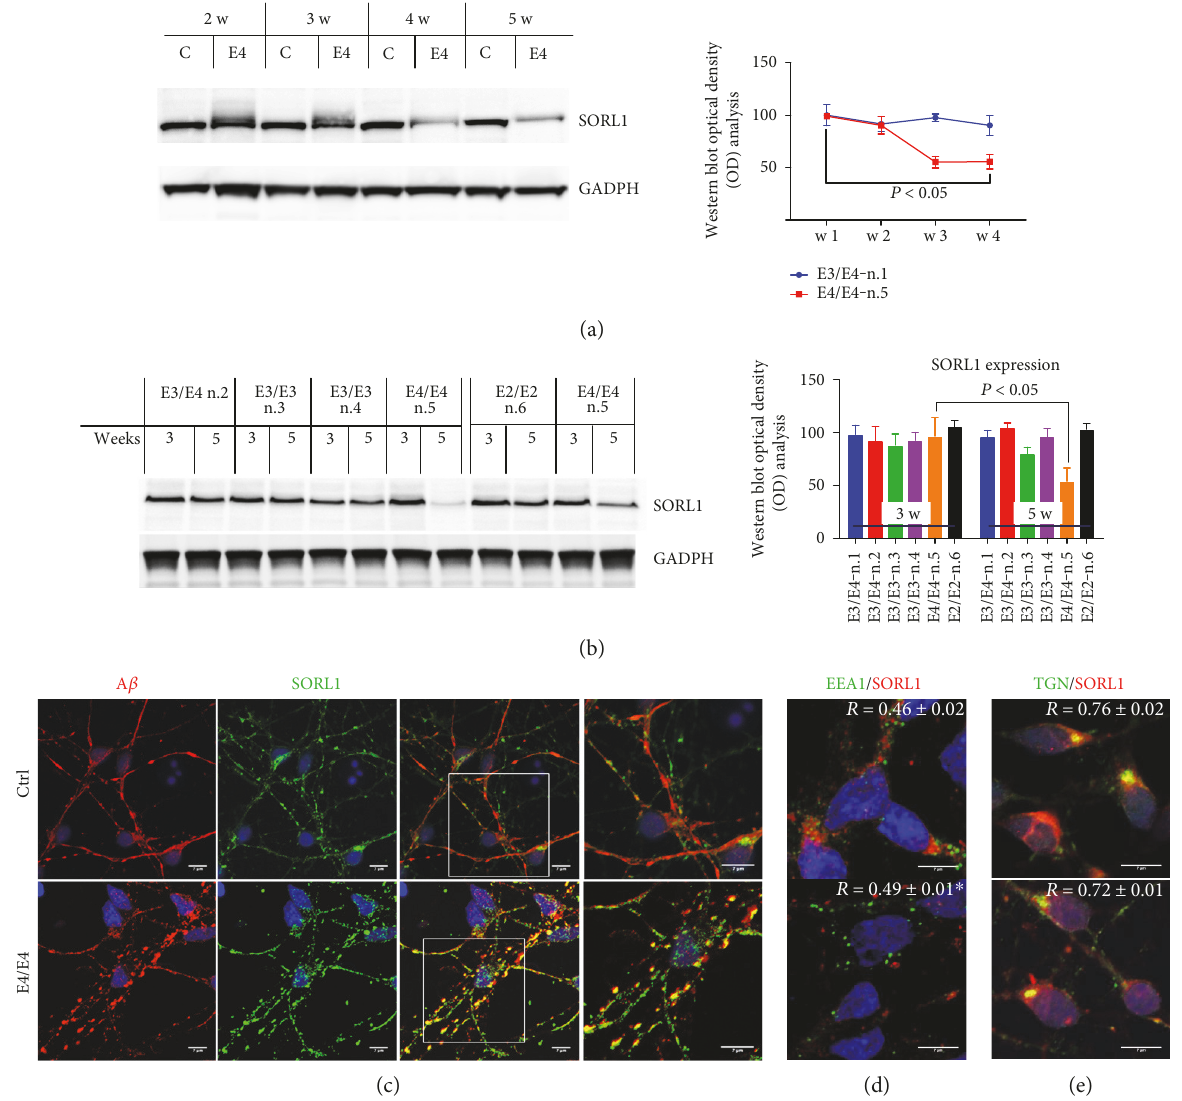
Figure 2: SORL1 expression is decreased in neurons carrying the E4/E4 genotype. (a) WB analysis of SORL1 from control (C, n.1) and E4/E4 (E4) neurons from two to fi ve weeks in culture. SORL1 expression levels were normalized to GADPH and expressed as % of the control (n.1). The quanti fi cation of band intensities (OD) is reported on the right. n = 4 , P < 0 05 versus week three. One-way ANOVA with post hoc Tukey ’ s test. (b) WB analysis of SORL1 in neurons with or without APOE4 allele expression after three and fi ve weeks in culture. SORL1 expression levels were normalized to GADPH and expressed as % of the control (n.1). The fi gure also reports SORL1 expression levels in 74-year healthy donors (n.6). The quanti fi cation of band intensities (OD) is reported on the right. n = 4 ; one-way ANOVA with post hoc Tukey ’ s test. P < 0 05 versus three weeks. (c) Confocal microscopy analysis of control and E4/E4 neurons after 5 weeks. Neurons are marked with mouse anti-A β and rabbit anti-SORL1 antibodies. High magni fi cation is shown on the right. Colocalization analysis of control and E4/E4 neurons by using (d) mouse anti-EEA1 and rabbit anti-SORL1 antibodies and (e) mouse anti-TGN and rabbit anti- SORL1 antibodies. Colocalization analysis was performed using the Zen software. The ( R ) coe ffi cient (Pearson ’ s coe ffi cient) was used for quantitative comparisons between control (Ctrl) and E4/E4 neurons ( R ). The data are expressed as mean ± SEM. n = 10 Student ’ s t -test ∗ P < 0 05 versus control